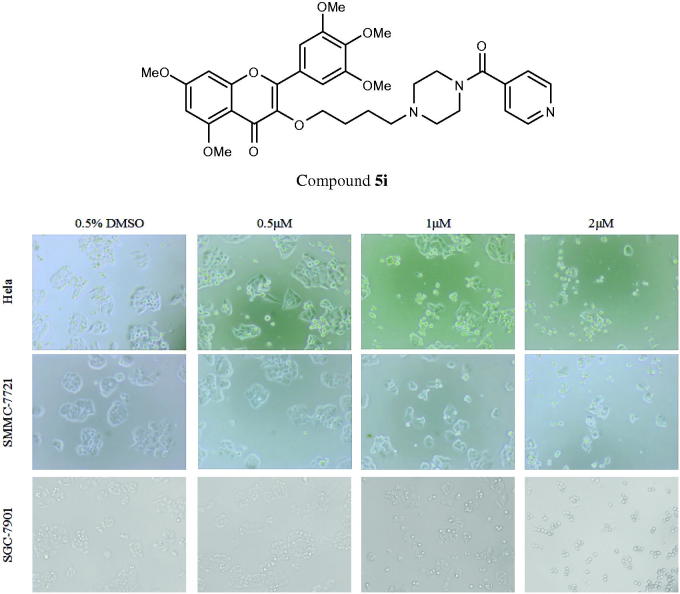
Cell morphology effectsa. aHela, SMMC-7721 and SGC-7901 cells were treated with compound 5i at 0.5 μM, 1 μM and 2 μM for 48 h.